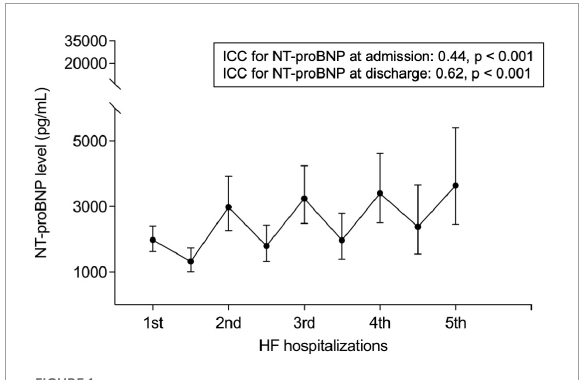
FIGURE1 NT-proBNP levels during the course of recurrent HF hospitalizations. ICC stands for intraclass correlation